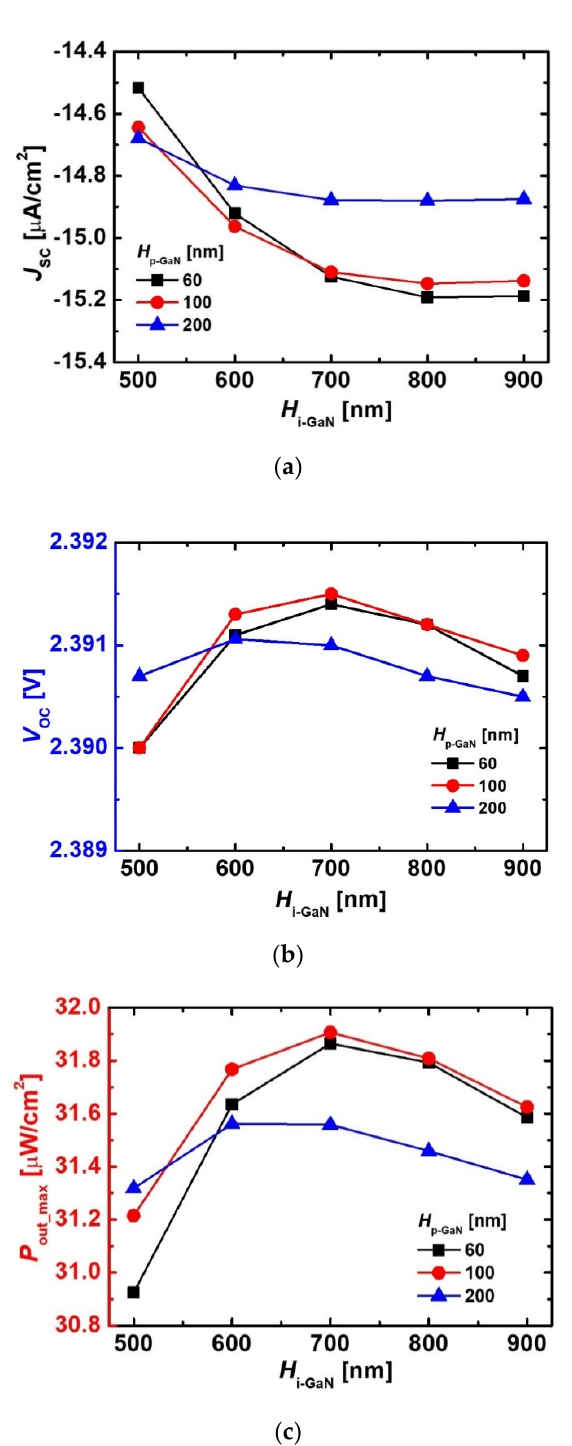
Figure 4. Variations of ( a ) J SC , ( b ) V OC and ( c ) P out_max of the irradiated diodes dependent on the H i-GaN and H p-GaN . The D p-GaN , D i-GaN , and D n-GaN were 5 × 10 17 cm − 3 , 1 × 10 16 cm − 3 , and 5 × 10 18 cm − 3 ,